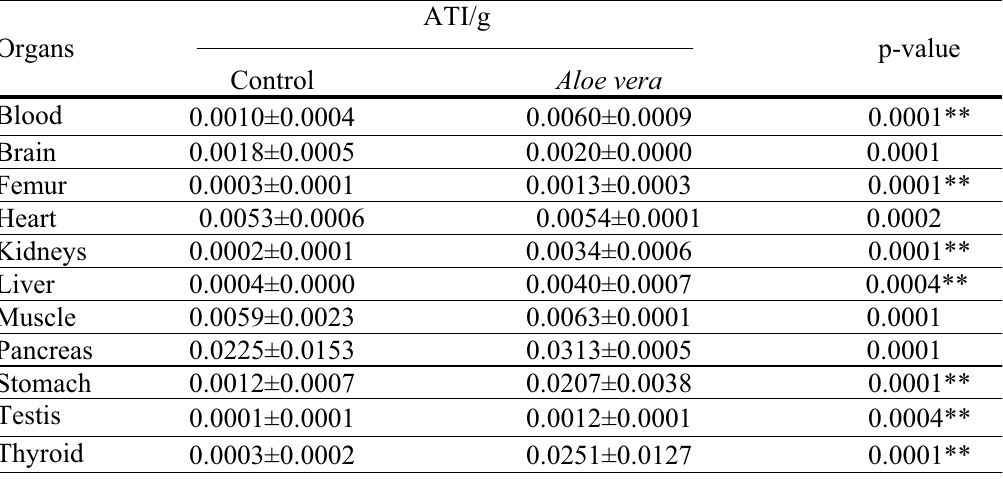
TABLE 1 - Effect of aqueous extract of Aloe vera on the %ATI/g in organs of Wistar rats after 60 min injection